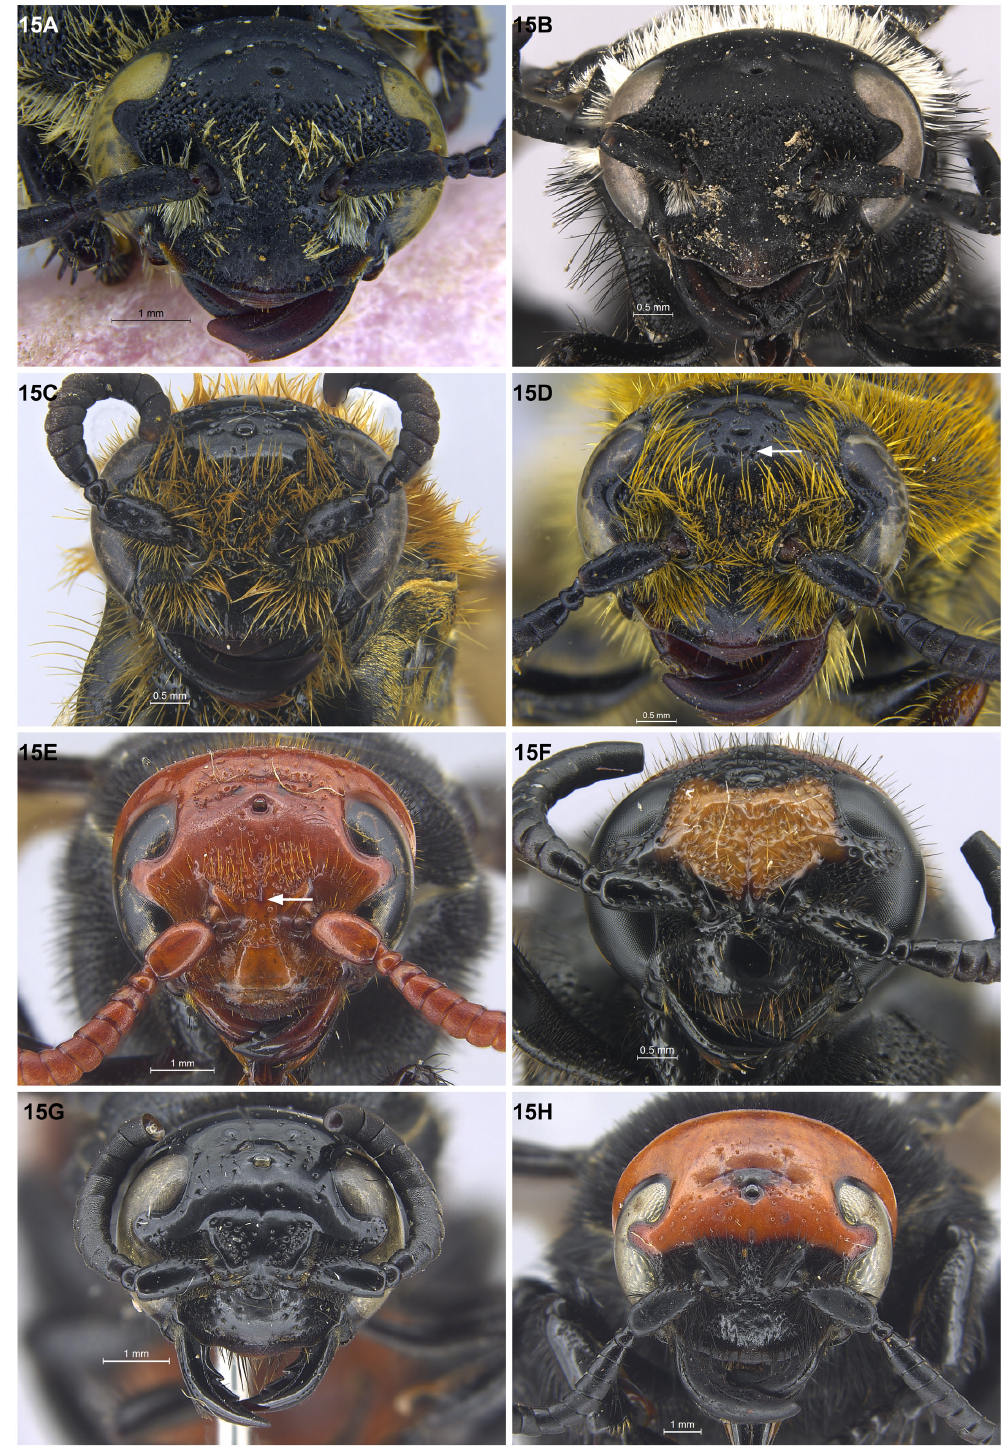
Fig. 15. Females, face. A . Campsomeriella annulata annulata (Fabricius, 1793). B . Camps. collaris (Fabricius, 1775) . C . Megacampsomeris formosensis chinensis Betrem, 1941. D . Phalerimeris phalerata phalerata (de Saussure, 1858). E . Austroscolia ruficeps ruficeps (Smith, 1855). F . Carinoscolia junnanensis (Betrem, 1928). G . Liacos erythrosoma (Burmeister, 1854). H . Megascolia azurea (Christ,